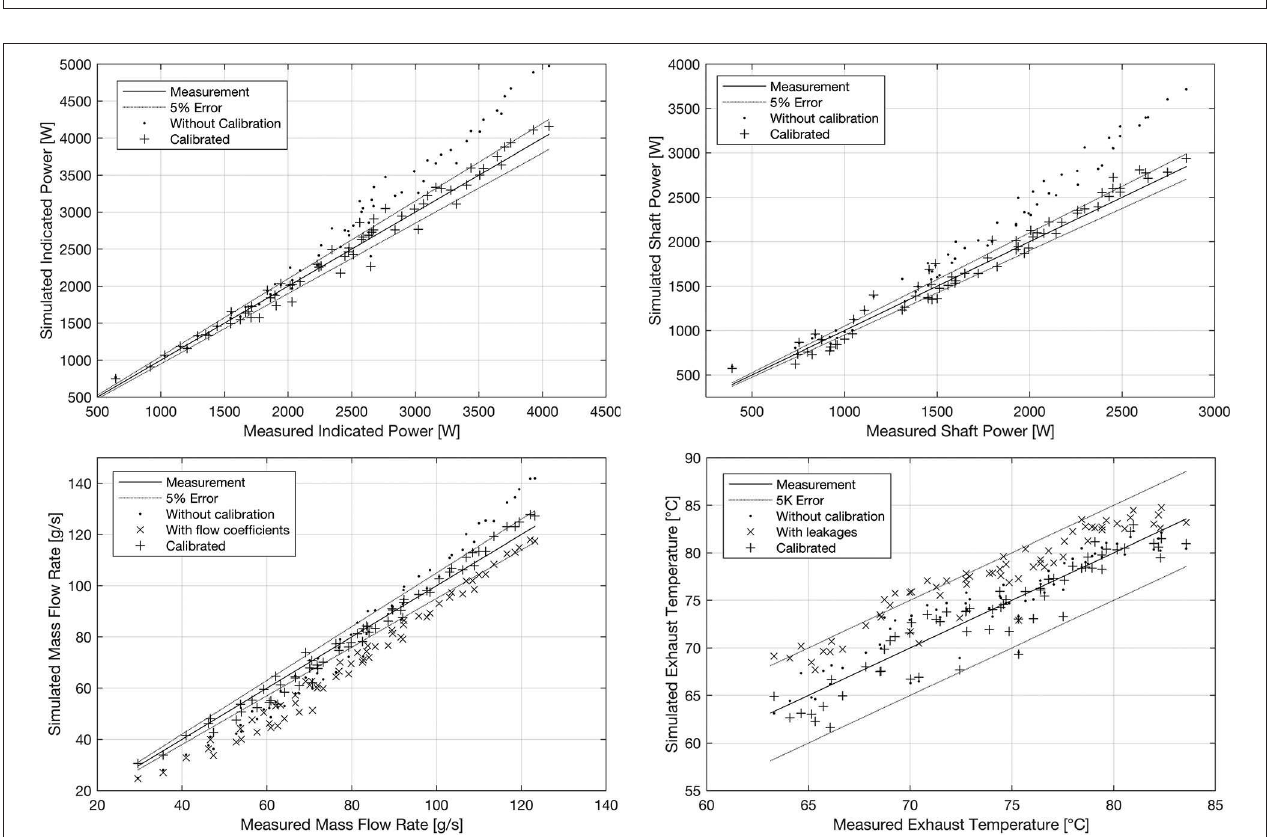
then overestimates the indicated power. In the calibration process, flow coefficients are set to 0.82 for the supply port and 0.6 for exhaust ports in order to obtain a good fit between measured and simulated pressure curves. With these values of flow coefficients, the model is able to predict, with good accuracy, the indicated power (see Figure 10 top left). The